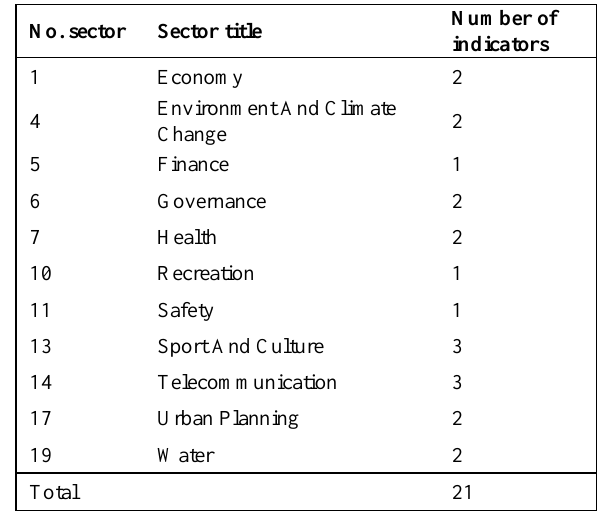
Table 1. The number of indicators per selected sector Sector determination is determined by the score value for each sector. The score is equal to or more than 0.5 to become the selected sector. In addition to the 21 indicators above, there are